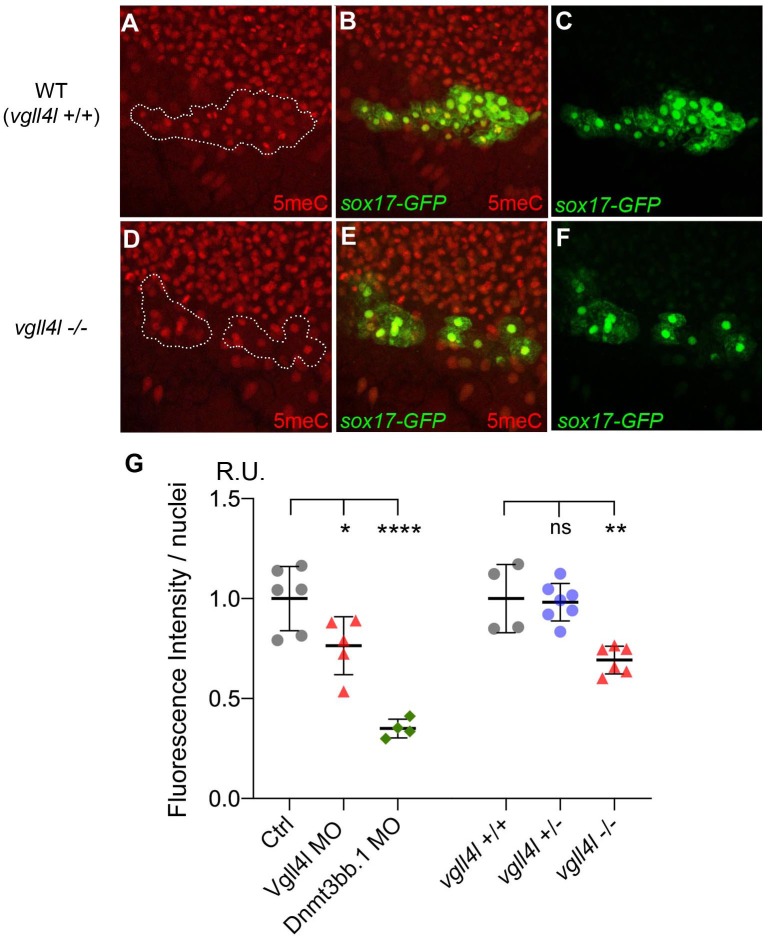
Effect of Vgll4l and Dnmt3bb.1 loss of function on DNA methylation in DFC nuclei.(A–F) Immunolabeling of DFC nuclei of embryos of the Tg(Sox17:GFP) strain with antibodies to five methyl Cytosine (5meC) in (A–C) WT and (D–F) vgll4l homozygous mutant. Dotted lines delimit the DFC clusters. (G) Quantification of DNA methylation measured by immunofluorescence intensity. The values on the graph correspond to the mean of 5meC fluorescence intensity per nuclei (FI/nuclei) quantified with the ImageJ software on all nuclei of DFC clusters in morphants for Vgll4l and Dnmt3bb.1 and in embryos from a cross between two heterozygous Vgll4l mutants that have been individually genotyped after measurement of FI/nuclei of their DFCs. Fluorescence intensity per nuclei is expressed in relative units (R.U.). Statistical significance between controls (standard MO or vgll4l +/+) and loss of function conditions: two-tailed unpaired t-test. ns, not significant (p>0.05), *p≤0.05, **p≤0.01, ***p≤0.001, ****p≤0.0001. Numerical data and details of statistical analysis for (G) are provided in Figure 10—source data 1.10.7554/eLife.45241.025Figure 10—source data 1.Numerical data for Figure 10G.